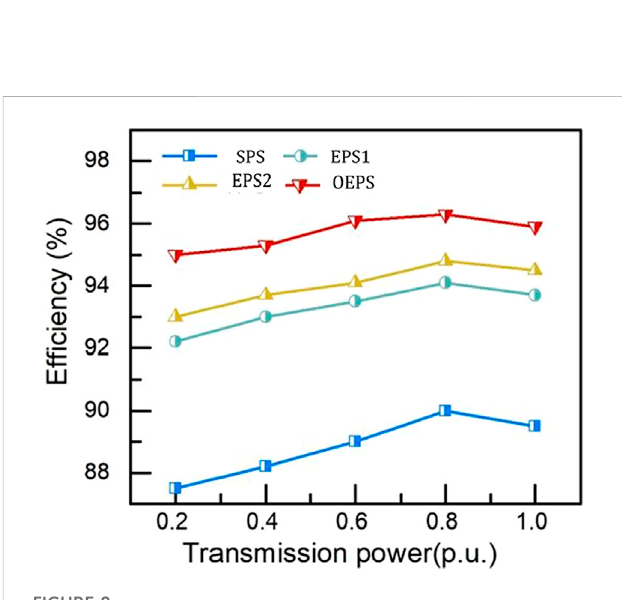
FIGURE 7 The soft-switching performance under different modulation schemes.